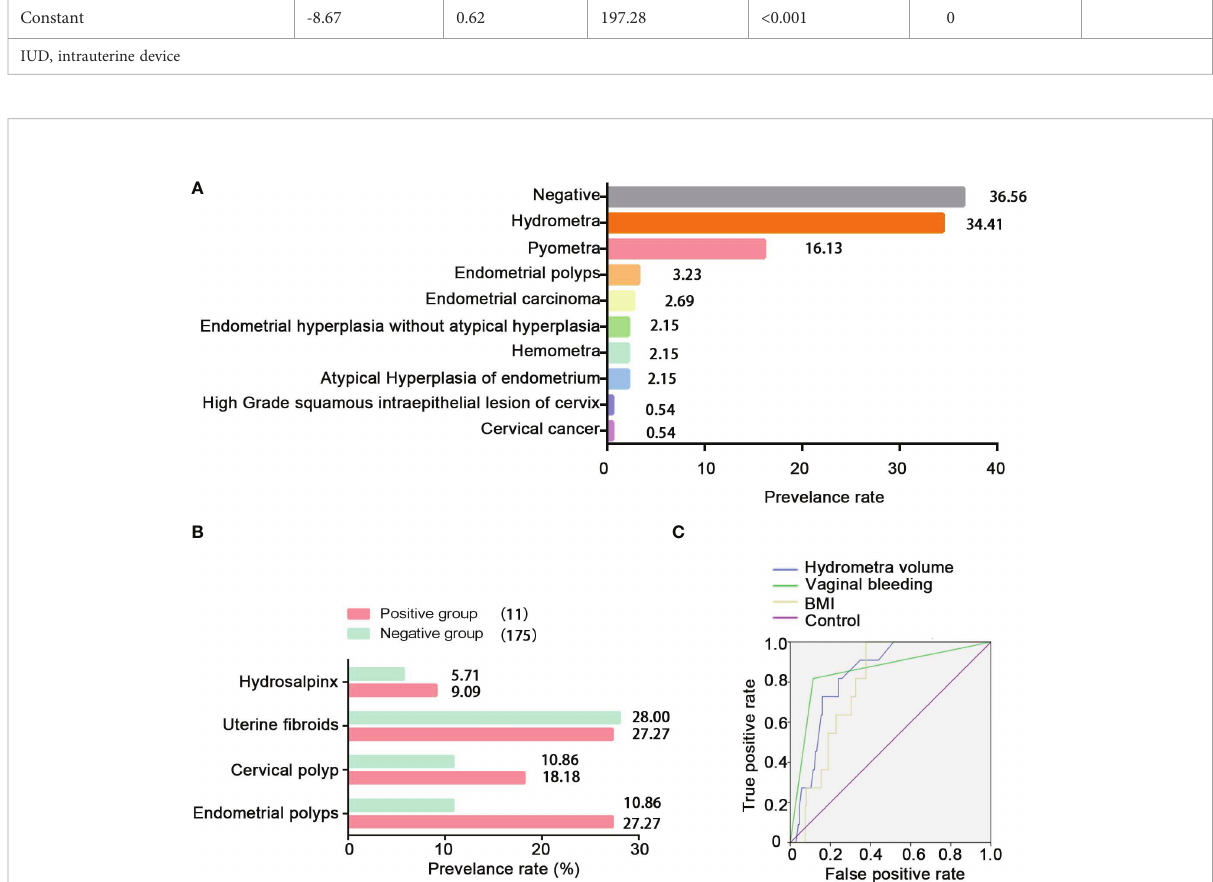
FIGURE 2 Pathological distribution of hydrometra and its predictive value in gynecological tumors. (A) Pathological distribution of sonographic diagnosis of hydrometra. The y -axis represents different pathological diagnoses, and the x -axis represents prevalence rate. (B) Comparison of hydrosalpinx, uterine fi broids, cervical polyp, and endometrial polyps between the positive group and the NC group. (C) ROC analysis to assess the predictive value of hydrometra volume, hydrometra complicated with BMI, or hydrometra complicated with abnormal vaginal bleeding in gynecological